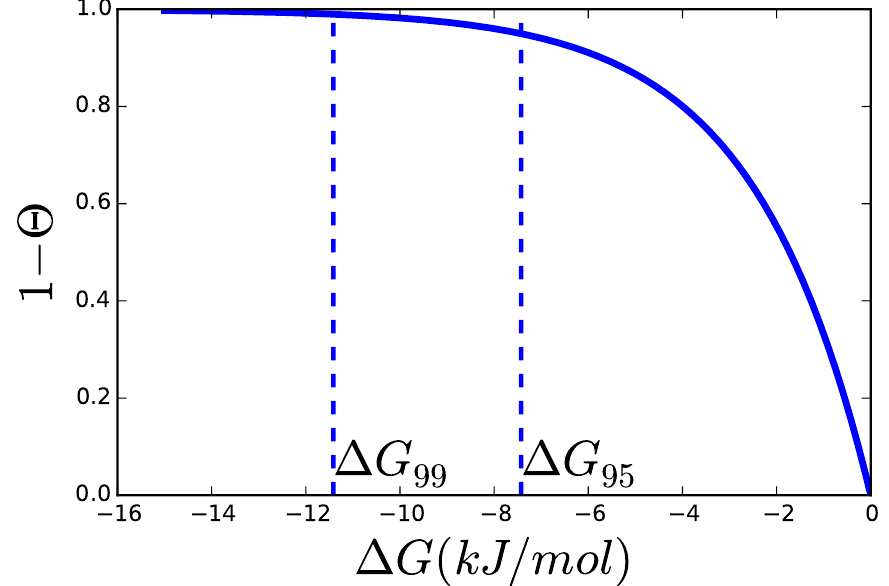
Figure 4. When ∆ G is similar enough to R T (typically assumed to be 2.48 kJ/mol for biochemical reactions), the thermodynamic factor, 1 − θ , decreases rapidly, since θ = exp ( ∆ G ) . ∆ G and ∆ G are the affinities at which the enzyme can operate at 95% 95% 99% RT and 99% of its V max